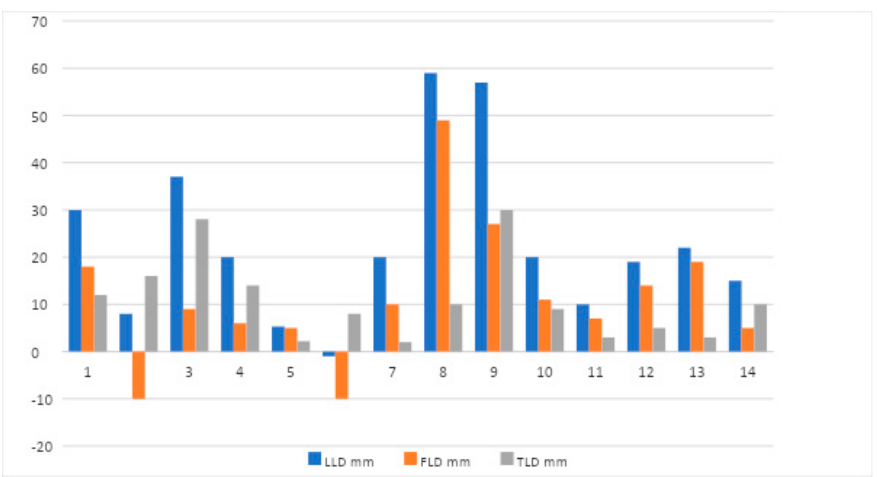
Figure 3. A histogram of the 14 patients who showed radiological evidence of leg length discrepancy.